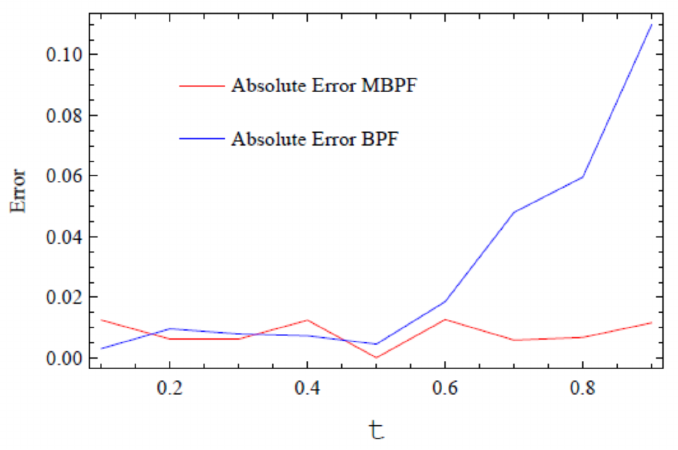
Figure 12. The absolute error of IBPFs and BPFs expansions comparison at random